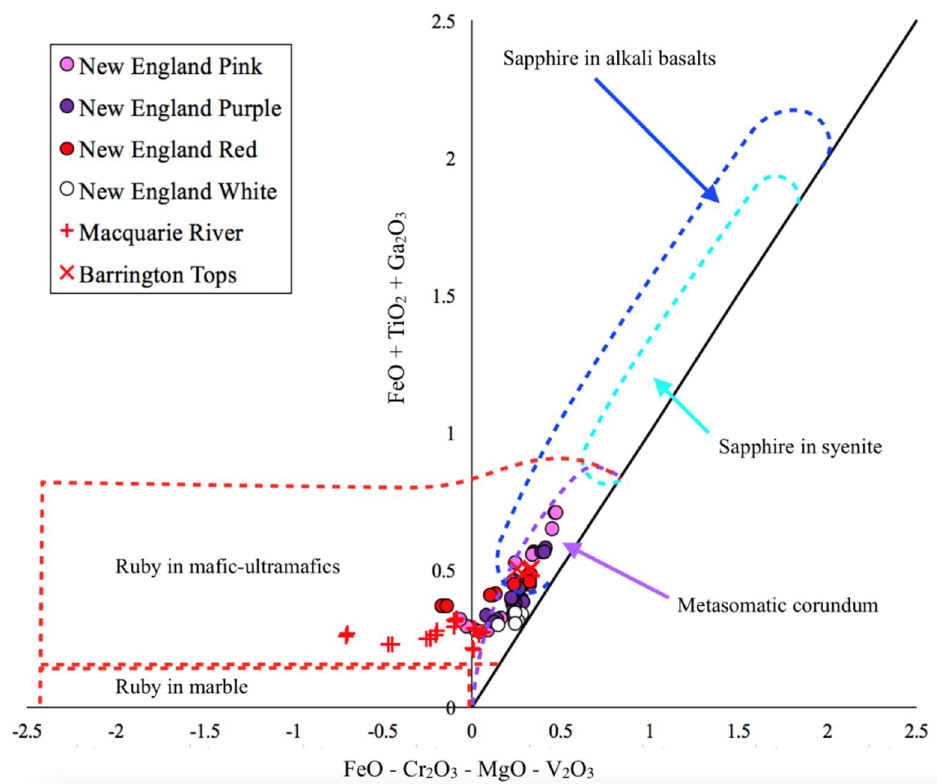
Figure 18. Discrimination diagram of metal oxide plots, within petrological fields after [3], for East Australian plots from Barrington Tops, Macquarie River and New England rubies. Plots are color coded to show the range of color and zoning. Symbols for different localities are shown in the legend.